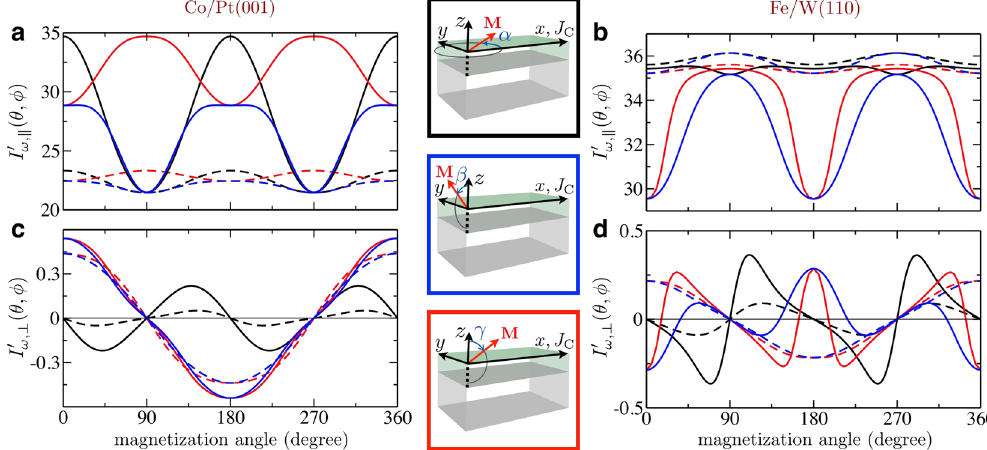
Figure 3. Dependence of the dc and ac longitudinal and transverse charge currents on the direction of the magnetization. Longitudinal ( ′ ω I ) and transverse ( ′ ω ⊥ I ) in-phase currents, ( a,c ) for Co/Pt(001) and (b,d) for , , Fe/W(110). The different rotation planes are illustrated on the middle panels: on the xy plane (black, α ), zy plane (blue, β ) and zx plane (red, γ ). The dashed curves correspond to an applied dc field: ′ ω I shows the AMR , behavior for the γ angular sweep (red) and the SMR behavior for the β sweep (blue), while both AMR and SMR are present in the α sweep (black); ′ ω ⊥ I shows the PHE behavior for the α angular sweep (black) and the AHE , behavior for the β γ , sweeps (blue, red). Solid lines correspond to an applied ac field with the frequencies ω = . 1 3 for Co/Pt(001) and ω = . 1 45 for Fe/W(110), close to the ferromagnetic resonance frequency. The anisotropy in the transport properties is greatly enhanced and the angular dependence becomes non-trivial due to the variation in the amplitude and shape of the magnetization precession.